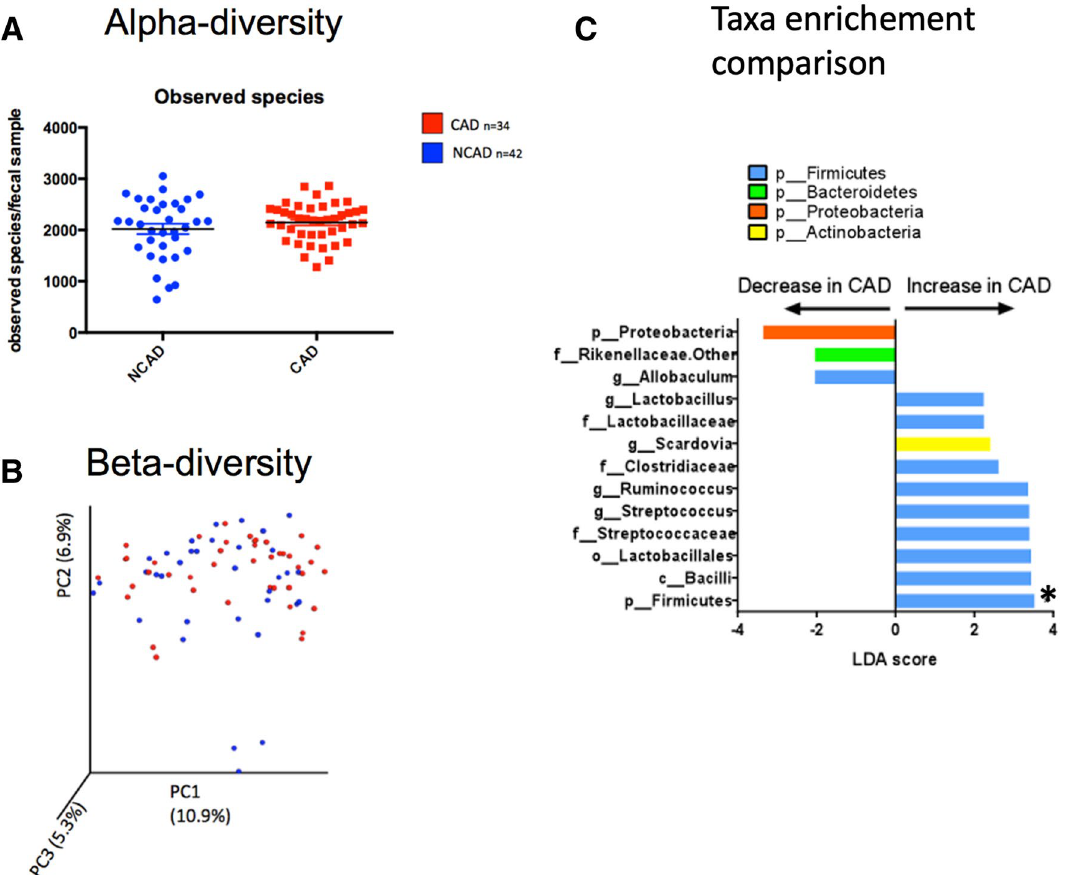
Figure 6. Descriptive and comparative analysis of the fecal microbiota in both patient samples: ( A ) Intra sample bacterial diversity, represented by the alpha diversity index, and illustrated by the number of bacterial species observed in each fecal sample. ( B ) Inter sample bacterial diversity, represented by the beta diversity index, illustrated by the Bray Curtis distance analyzed by primary component analysis. ( C ) Bacterial taxa enrichment in patients with coronary artery disease using LeFSE analysis.* Taxa significant after adjustment for age and gender, using a multiple variable association with linear models. NCAD = Non-coronary artery disease; CAD = Coronary artery disease. Image credit: Figure A and ( B ): Graphpad 6.0, https:// www. graph pad. com/ scien tific- softw are/ prism/. Figure ( C ): LEfsE, https:// hutte nhower. sph. harva rd. edu/